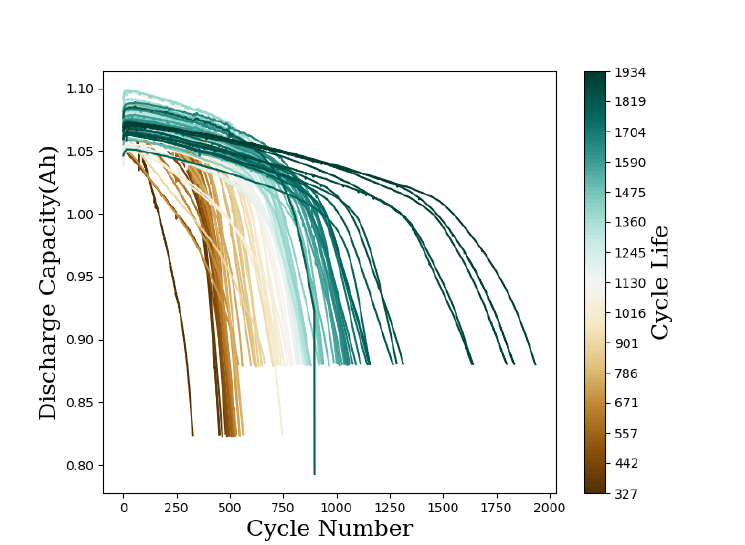
Figure 4. Discharge capacity versus cycle number of all analyzed cells. The different colors indicate the corresponding cycle life of each cell. The cells with shorter lives belonged to batch “2017-06-30”, which was cycled until 75% nominal capacity. The remaining two batches were cycled until 80% nominal capacity.